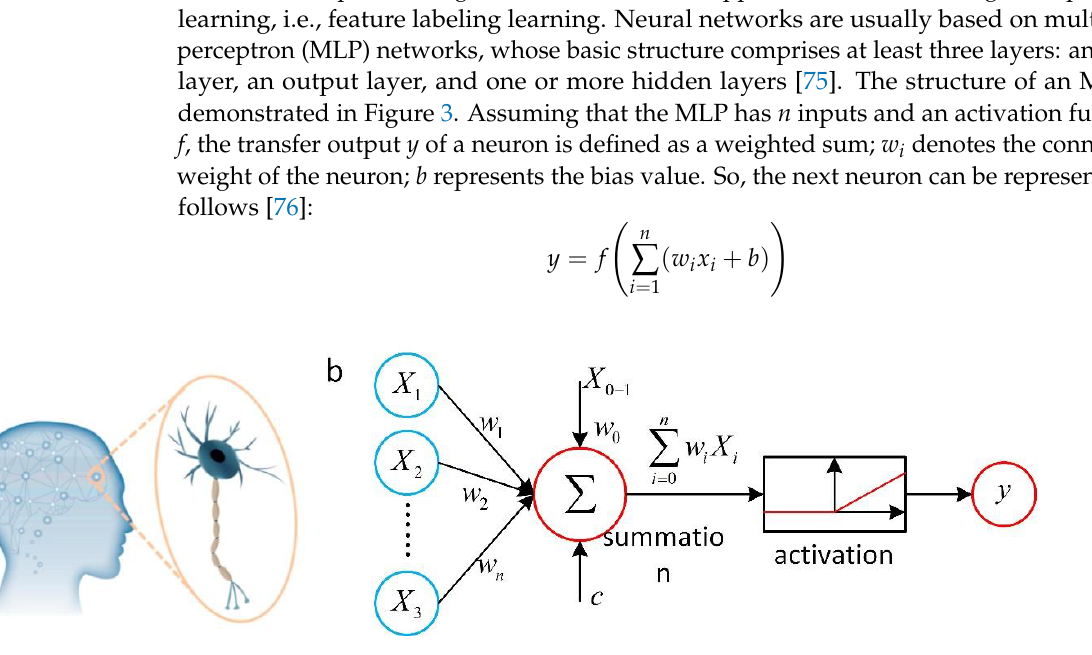
Figure 3. ( a ) Schematic diagram of the biological neural network. ( b ) Flow chart of data processing within a neuron. Reprinted with permission from Ref. [75] . Copyright 2021 Elsevier